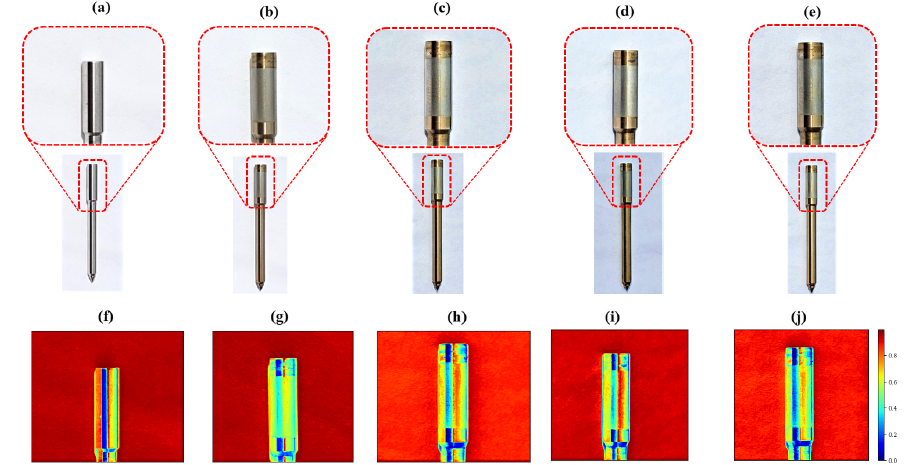
Figure A2. Comparison of injector nozzle needles between ( a ) normal injector, ( b – e ) the worn injectors after the experiment, and ( f – j ) the surface profiles for the respective injector valve